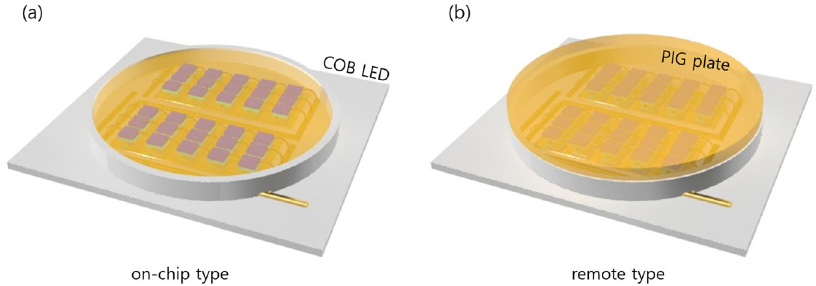
Figure 1. Schematic diagrams of the on-chip and remote configurations on COB-type